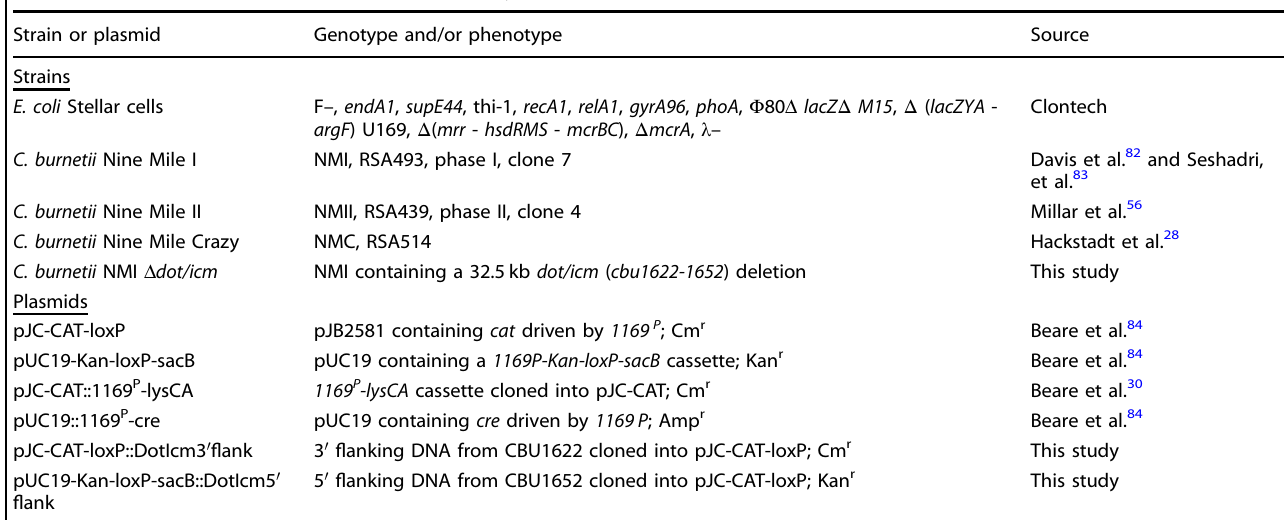
Table 2. Bacterial strains and plasmids used in this